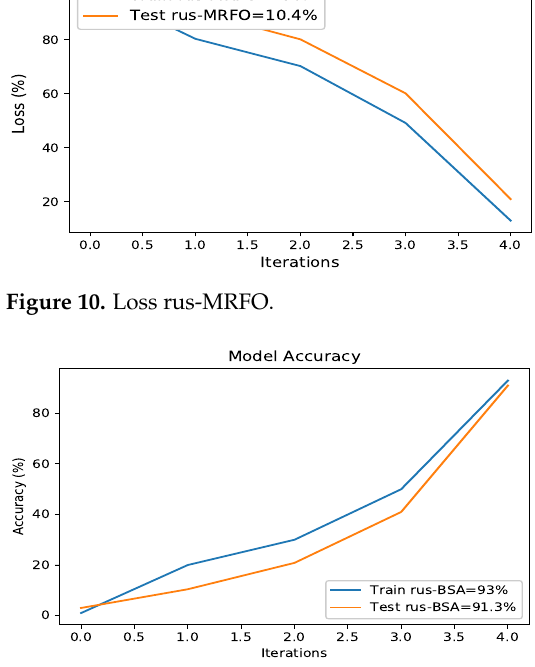
Figure 11. Accuracy rus-BSA.